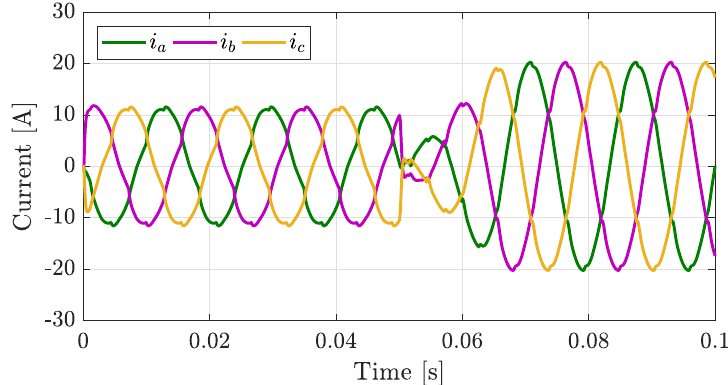
Figure 15. Compensation of PI controller tuned by poles placement method under balanced nonlinear conditions.